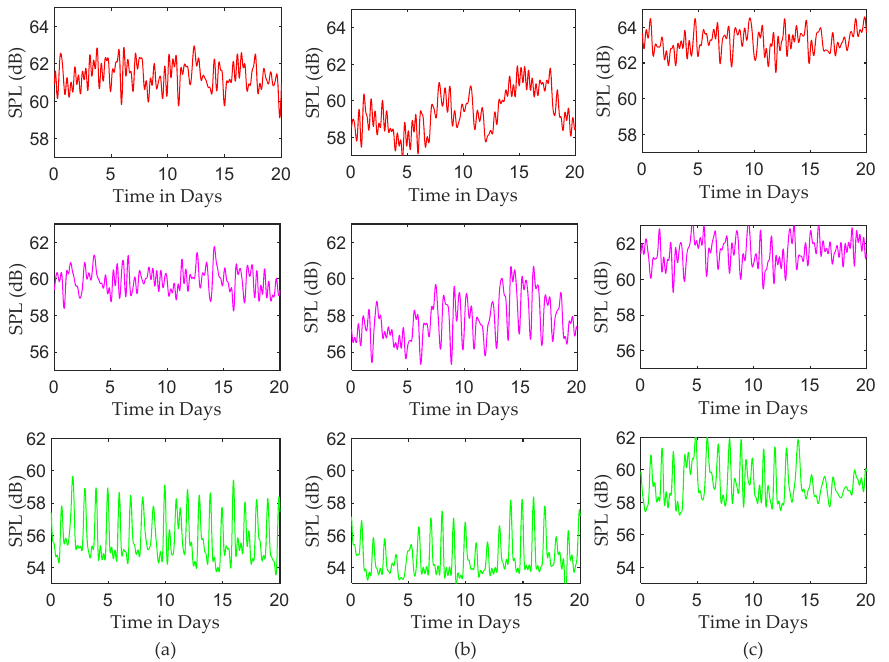
Figure 10. Reconstructed SPL time series for subgroups by employing IFFT to the first 64 points; red, pink, and green column plots are reconstructed SPL time series for daytime, evening, and night (each 8 h a day over 20 days): ( a ) ICU1, ( b ) ICU2, and ( c ) ICU3.